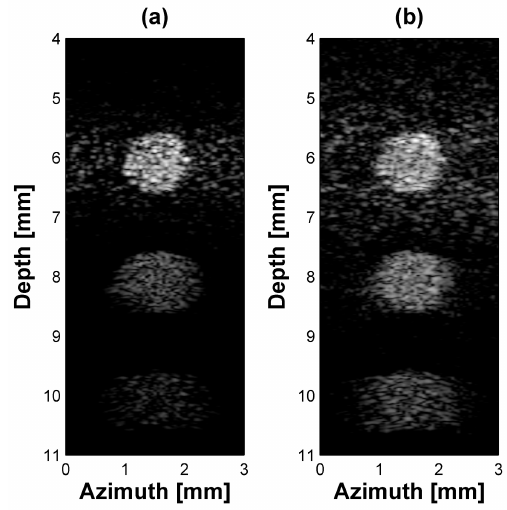
Figure 8. Cyst target simulation results for ( a ) single element and ( b ) dual-element transducer with phase inversion. All figures are logarithmically compressed with a dynamic range of 40